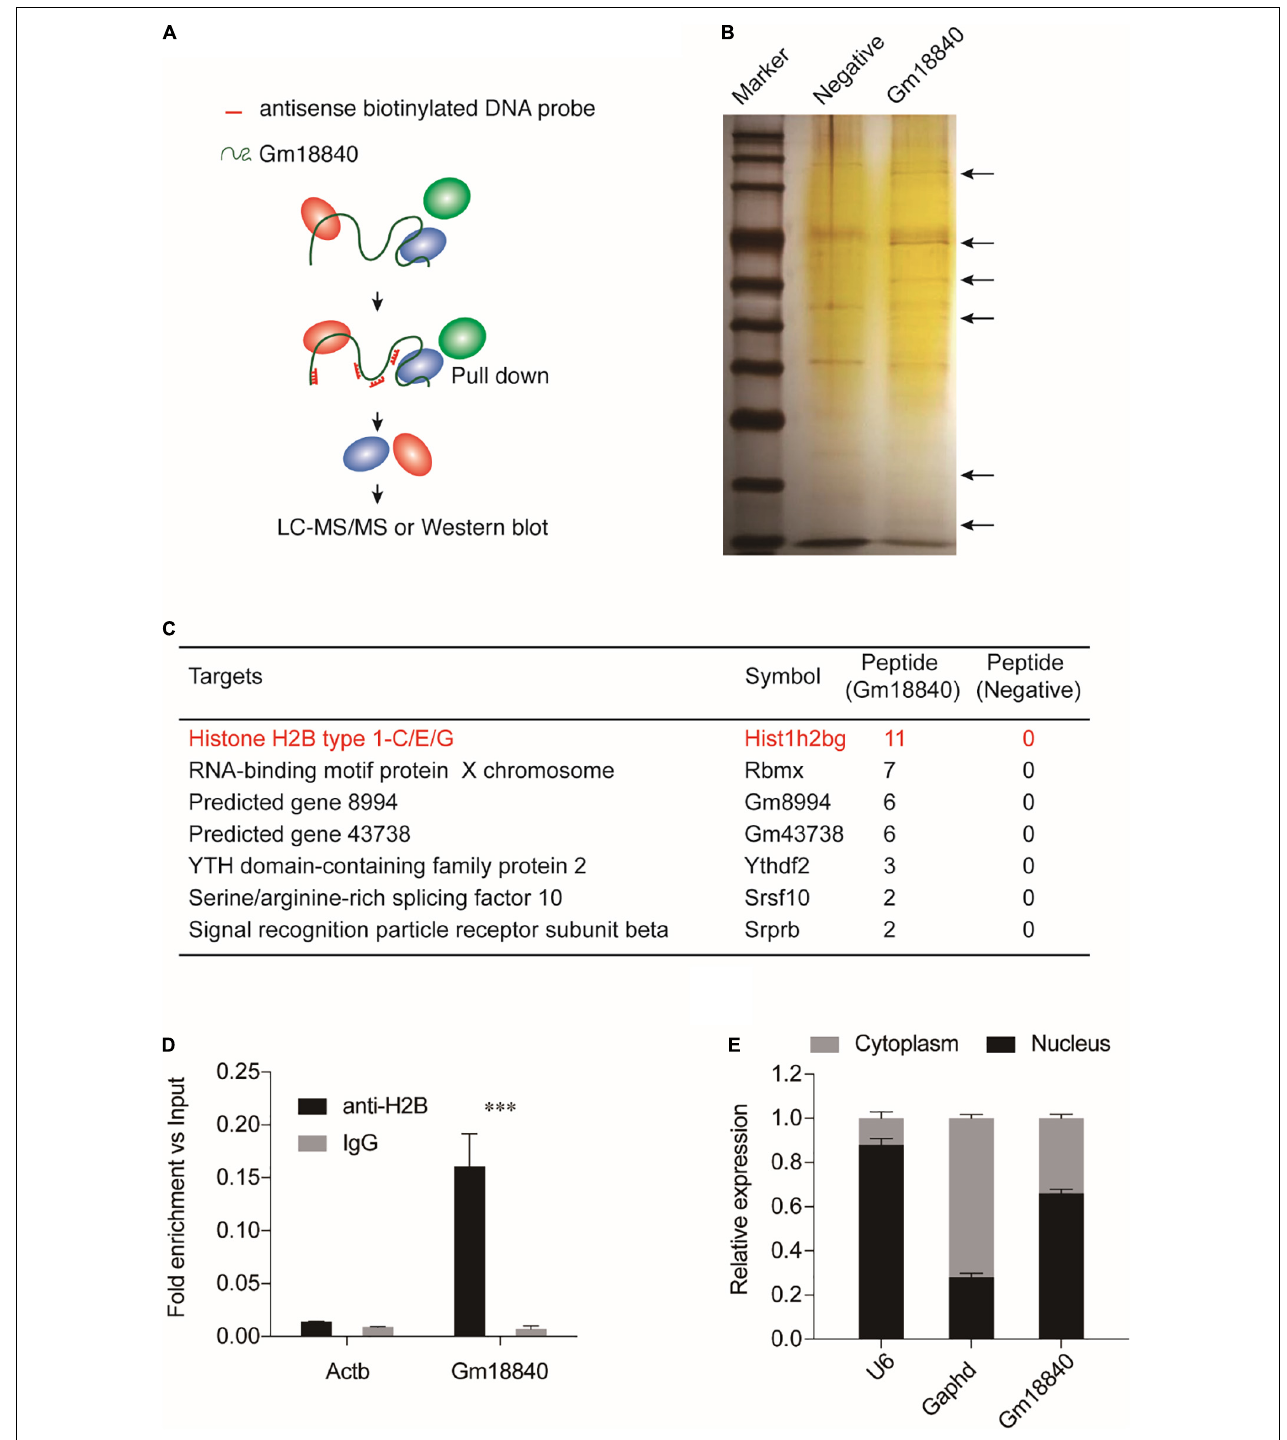
FIGURE 5 | Gm18840 interacted with histone H2B and was located in the nucleus and cytoplasm. (A) Schematic illustration of RNA pulldown assays. Biotinylated DNA against the Gm18840 lncRNA was used for RNA pulldown analysis. HL-1 cells were fixed with formaldehyde and sonicated. The Gm18840 lncRNA was hybridized with DNA probes, and the interacting protein of Gm18840 was captured. Primers against Gapdh were used as the negative control. (B) Silver staining showing the proteins uniquely bound by Gm18840 in HL-1 cells. (C) LC-MS/MS analysis of the Gm18840-interacting proteins. (D) RIP-qPCR analysis of the direct binding between H2B protein and the Gm18840 lncRNAs in HL-1 cells. (E) Distribution of Gm18840 in the cytoplasm and the nucleus. RNA was extracted from the cytoplasm and the nucleus, and the expression of U6 (mainly distributed in the nucleus), Gapdh (mainly distributed in the cytoplasm), and Gm18840 was detected. *** p <